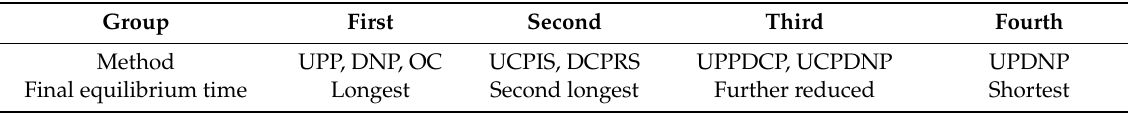
Table 2. Groups of the final equilibrium